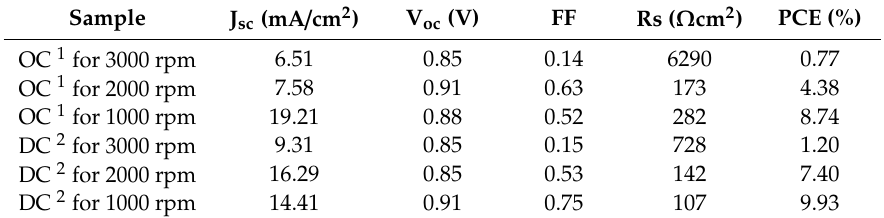
Table 1. Photovoltaic performance of perovskite solar cells with different TiO 2 concentration and various spin ‐ coating speeds.